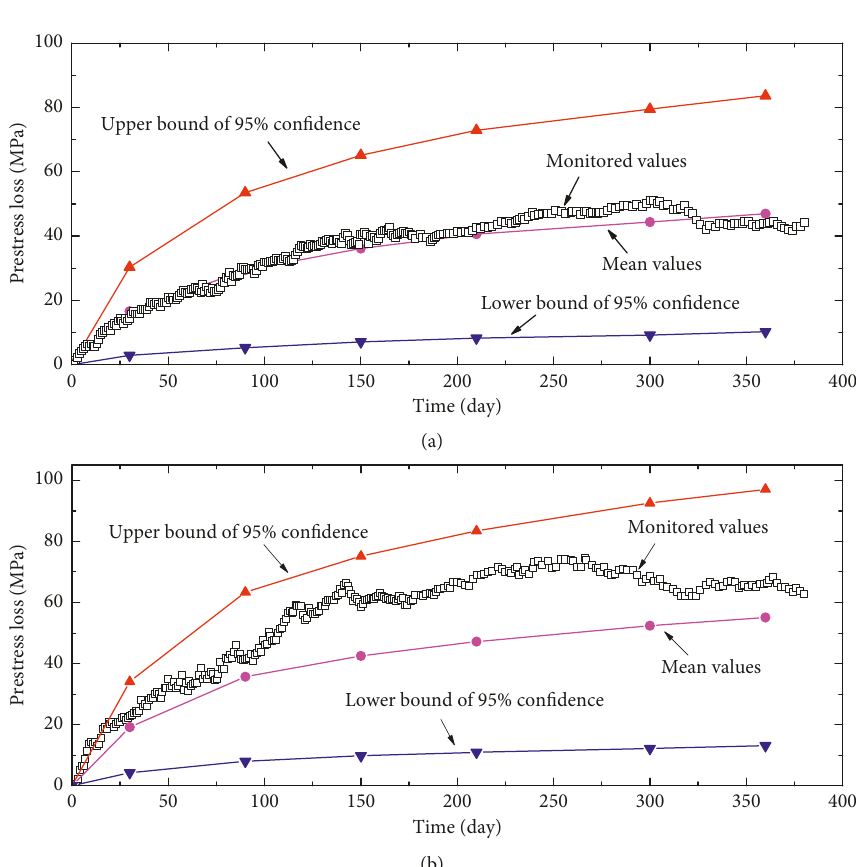
Figure 11: Comparison of probability results of long-term loss with measured values. (a) PC1. (b)